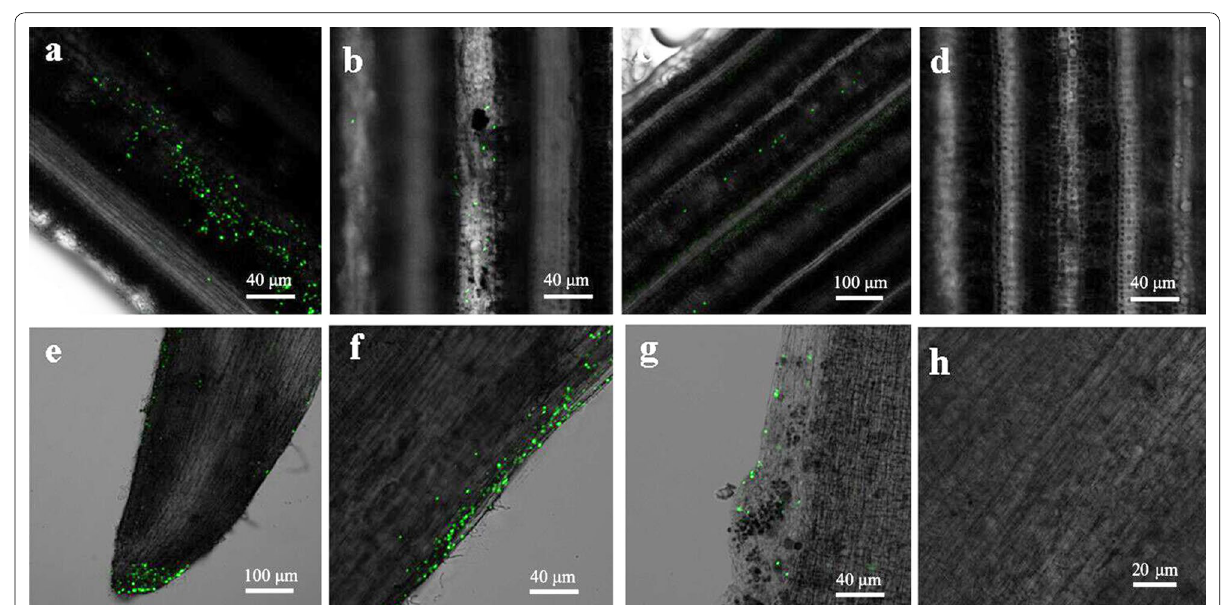
Fig. 5 CLSM images of colonization of strain GJ-22-gfp on the leaves and root of rice. a – c and e – g were the results of foliar and root treatment for 24 h, 48 h and 72 h respectively. a Cells were lined up along the surface layer; b cells were observed linear distribution in the leaves damage area throughout the entire length; c single cells occupied the longitudinal intercellular space of mesophyll epidermal cells linearly of leaves in rice; e cells were seen adsorbed on the root apex, root cap of rice; f cells were distributed linearly in the root extension; g most fluorescence cells were distributed on the root extension of rice. No fluorescence cells were found on the rice leaf d and root h with the uninoculated treatment. Magnification: 20. And the experiment was repeated seven ×